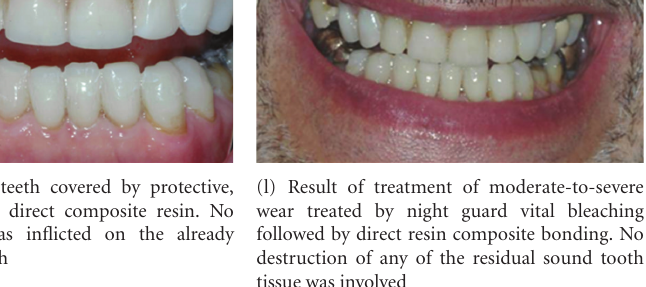
Figure 8: Patient showing moderate-to-severe wear treated by night guard vital bleaching followed by direct resin composite bonding. No destruction of any of the residual sound tooth tissue was involved.